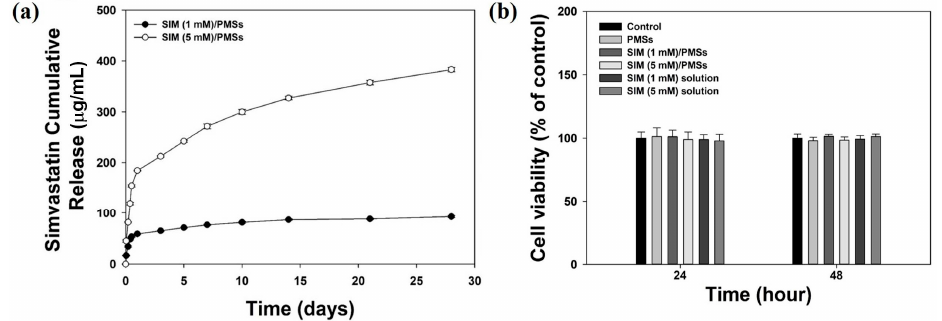
Figure 2. ( a ) In vitro release profiles of simvastatin from SIM (1 mM)/PMSs and SIM (5 mM)/PMSs. ( b ) Cytotoxicity of simvastatin (1 mM and 5 mM), PMSs, SIM (1 mM)/PMSs, and SIM (5 mM)/PMSs at 24 h and 48 h. Error bars represent the means ± SDs ( n = 5).